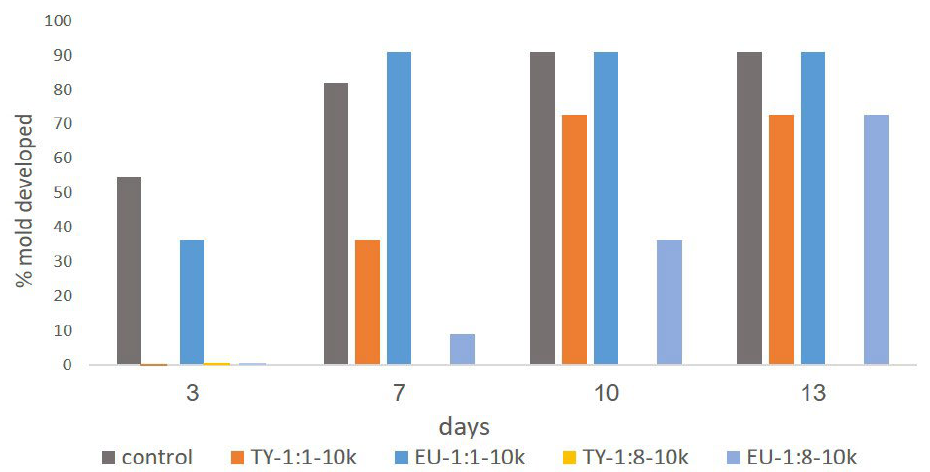
Figure 7. Mold development observations of alfalfa plant in a Petri dish exposed to the different emulsions. Observations performed after 3, 7, 10 and 13 days of incubation. A Petri dish with no emulsion was used as the control.